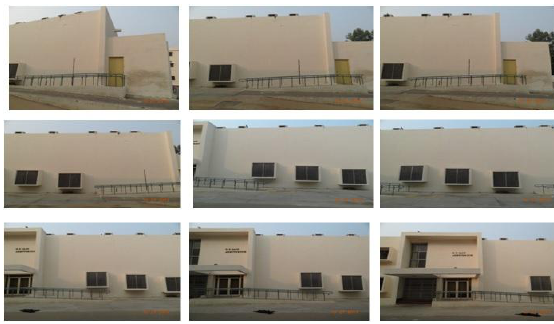
Figure-7, showing the example of some photographs, suitable for Agisoft Photoscan project.